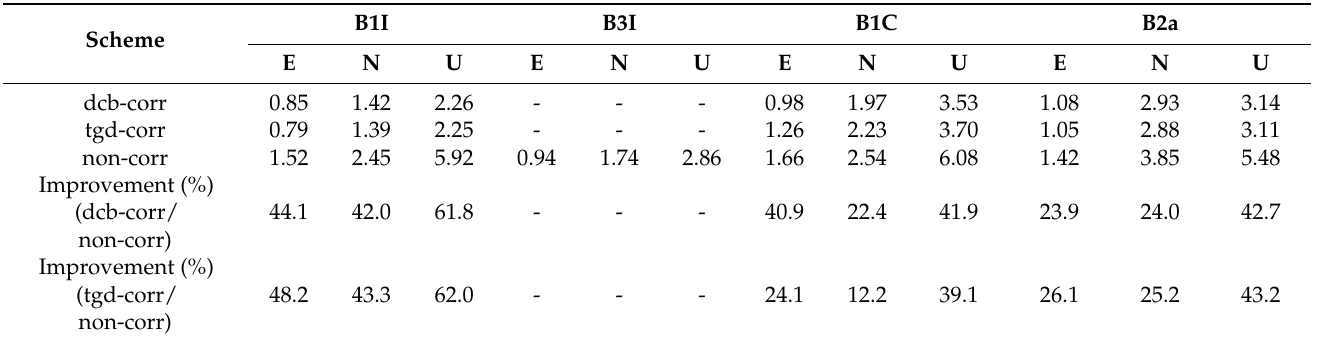
Table 4. RMS in BDS-3 single-frequency SPP performance with different schemes